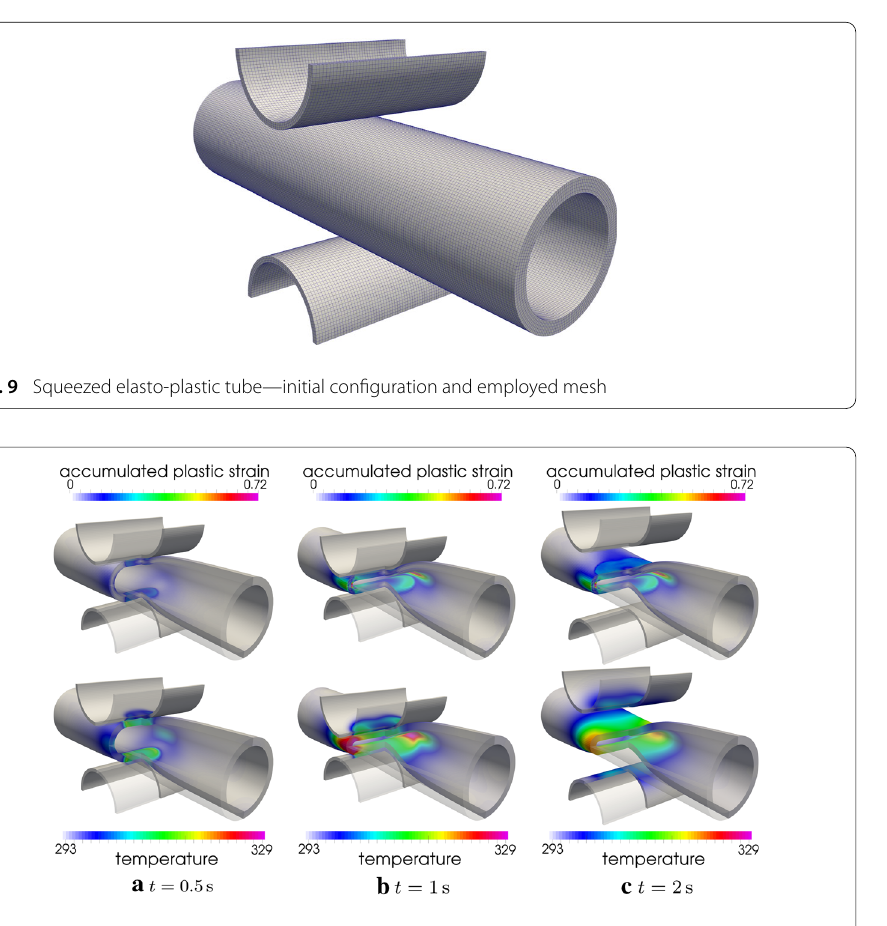
Squeezed elasto-plastic